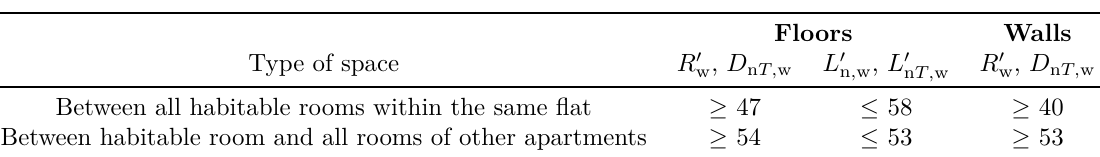
Table 1. Required sound insulation between habitable rooms in family houses and residential buildings [1].